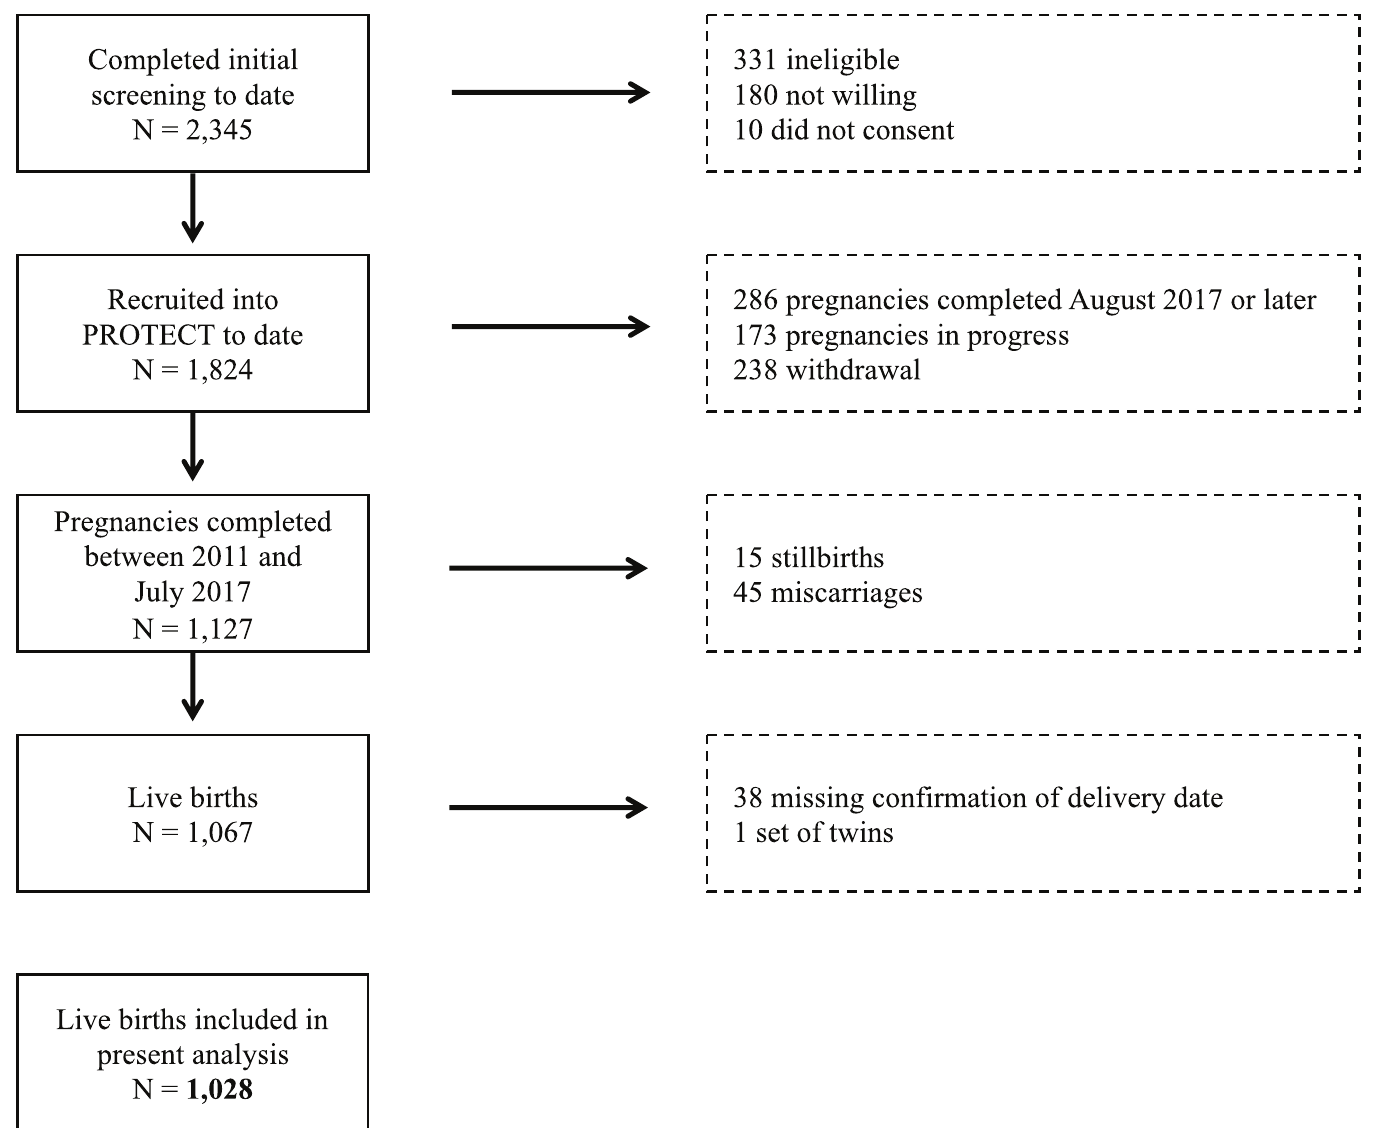
Fig 1. Participants from the Puerto Rico Test site for Exploring Contamination Threats (PROTECT) pregnancy